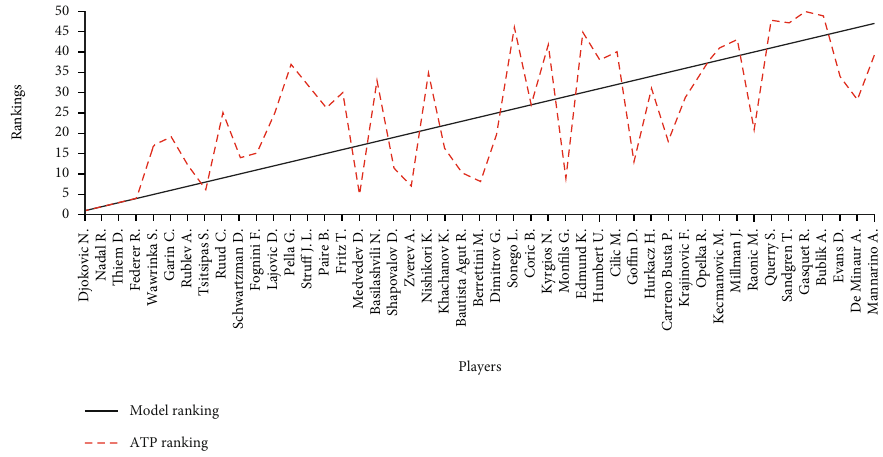
Figure 7: Comparison of model ranking with ATP ranking for top 50 tennis players on clay court.